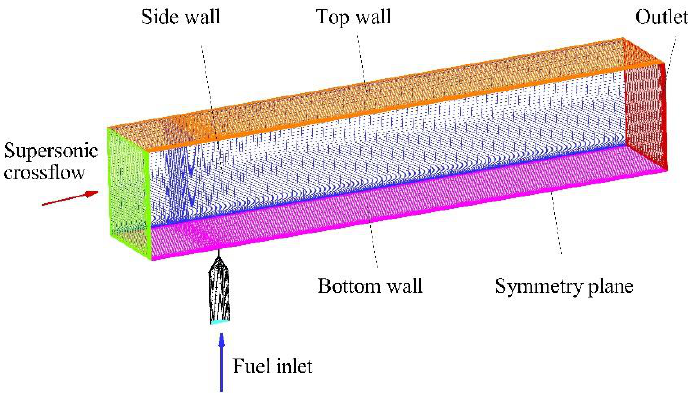
Figure 4. Schematic of computational domain, boundary conditions, and mesh.